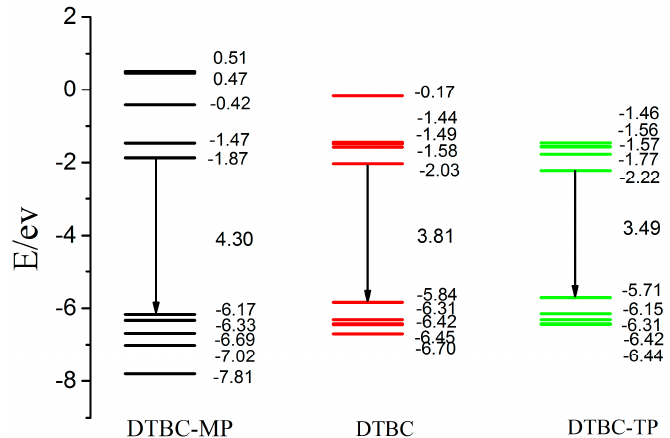
Figure 3. The calculated eigenvalues of frontier molecular orbitals and HOMO-LUMO gaps for DTBC-MP, DTBC, and DTBC-TP in chloroform (CAM-B3LYP/6-31g(d,p)).